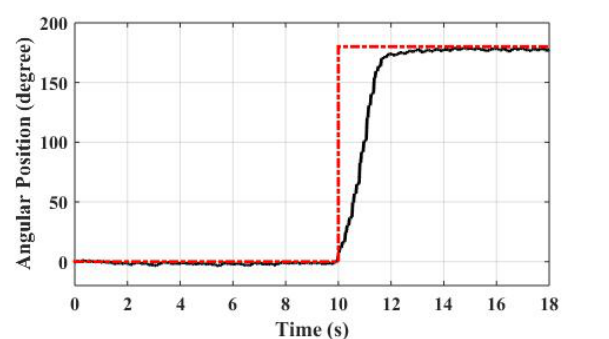
Figure 9. Angular position of the rotational platform.